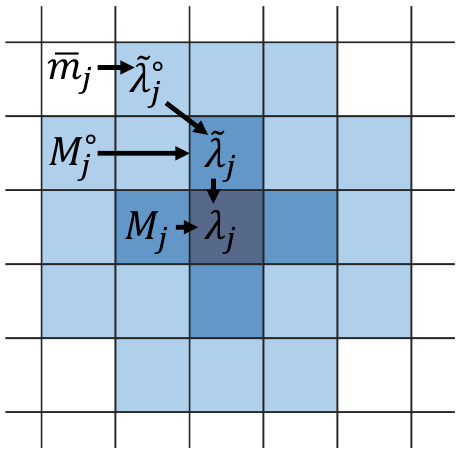
Figure 3. A diagram showing the relevant parameters for calculating the local retrodiction at pixel j (dark blue). The intensity λ j is calculated by retrodiction based on the number of photons detected within a radius of R 0 from pixel j , M j . R 0 = 1 in this example, shown in mid-blue, and is used in most of the work presented here. The number of pixels contributing to M j is N j . The local prior ˜ λ j is calculated from the the data contained within a radius R 0 < R < R 0 + 1 (in light blue), where there are M ◦ detected counts from N ◦ pixels, and from a further prior ˜ λ ◦ . This further prior is calculated j j j ) / ( N + N ◦ ) ≈ ¯ m from the average of measurements in the rest of the image ¯ m j = ¯ m − ( M j + M ◦ j j j